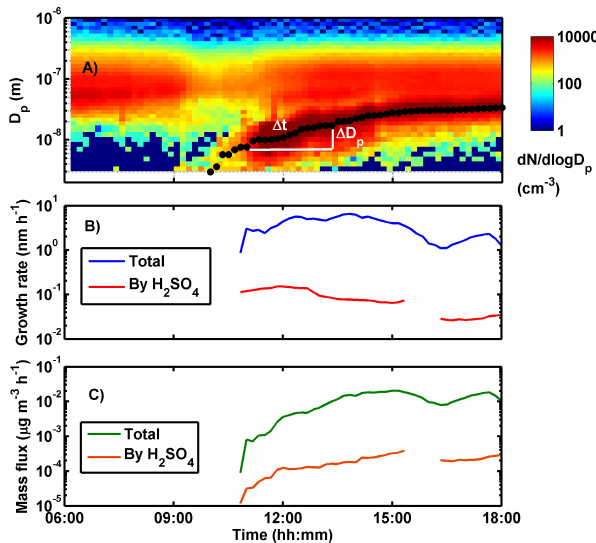
Fig. 2. Aerosol formation and growth event on 15 April 2007 at the SMEAR II station in Hyyti¨al¨a, Finland. (A) Evolution of aerosol number size distribution. The black dots represent the geometric mean size of the nucleation mode. (B) Particle diameter growth rate (GR= 1D p /1t ) and (C) mass flux to the nucleation mode as determined from the data and calculated based on ambient sulfuric acid concentrations. The GR and mass flux by sulfuric acid are theoretical maximum